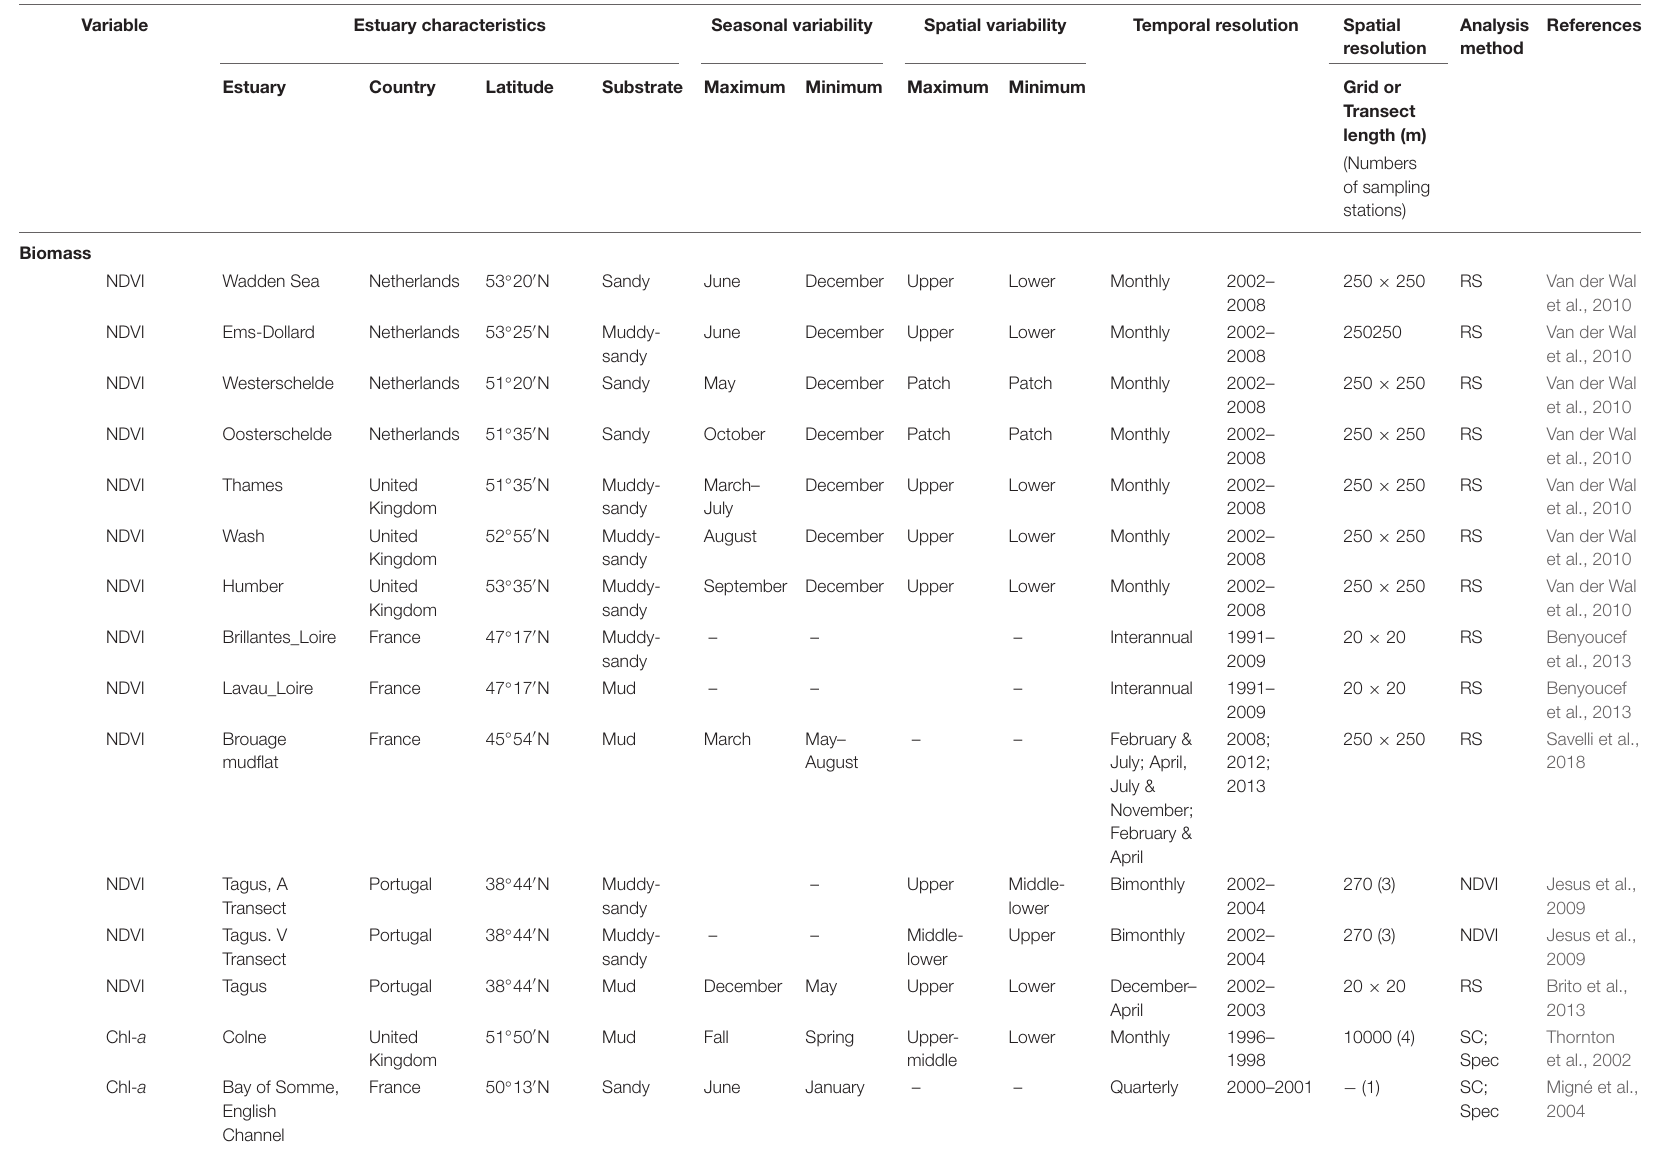
TABLE 3 | Temporal and spatial variability of the MPB biomass (Chl- a ), net production in light (PN), gross production (PG), and respiration in darkness (RD) in the intertidal areas of estuaries worldwide at latitudes from 53 to 33 ◦